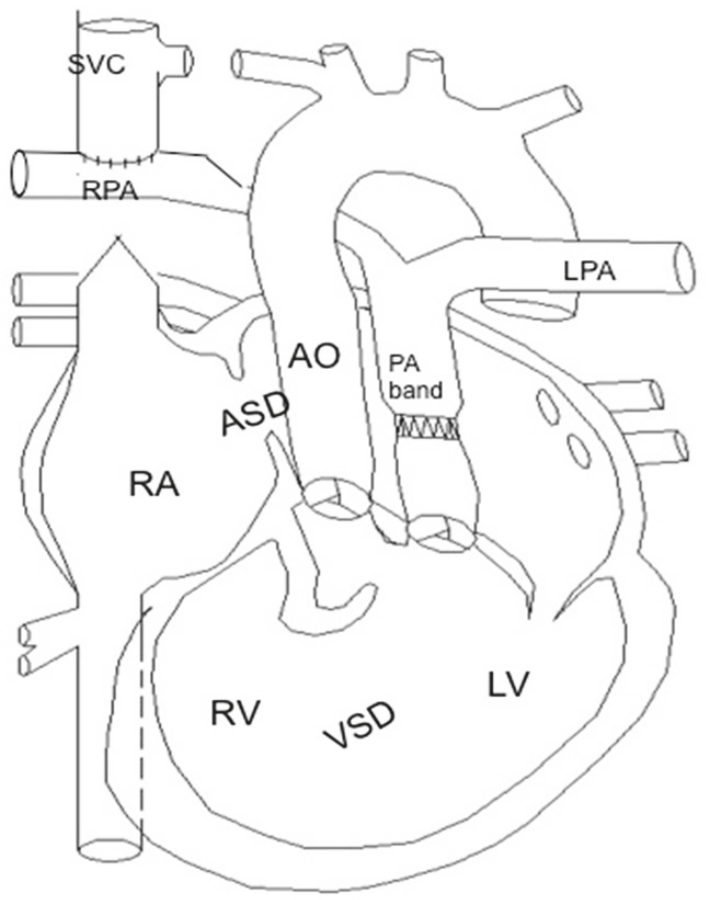
Figure 1: Patient’s abnormal cardiac anatomy (picture courtesy of cardiologist Dr. Tan Ju Le) . (1) Transposition of great arteries : the morphologic left ventricle is connected to the pulmonary artery (PA) and pulmonary circulation; the hypoplastic right ventricle is connected to the aorta andsystemiccirculation. (2) The tightpulmonaryarteryband limitsbloodflowfromtheleftventricleintothepulmonarycirculationtoprevent development of pulmonary hypertension and to direct oxygenated blood from left ventricle to right ventricle through the large nonrestrictive ventricular septal defect (VSD) and then from right ventricle to systemic circulation. (3) Systemic venous blood from the superior vena cava enters the pulmonary circulation for oxygenation via the bidirectional cavopulmonary connection . (4) Systemic venous blood from the inferior vena cava returns to the right atrium and enters left atrium via the large nonrestrictive atrial septal defect (ASD) , from left atrium to the morphologic left ventricle. Due to the congenital tricuspid atresia , there is no blood flow form right atrium to right ventricle. (5) Oxygenated blood from the lungs enters the pulmonary veins, flows to left atrium and left ventricle and then through the ventricular septal defect to right ventricle. Both the hypoplastic right ventricle and the left ventricle (via the ventricular septal defect) eject blood into the aorta. Bidirectional shunting occurs across the ventricular septal defect with mixing of oxygenated and deoxygenated